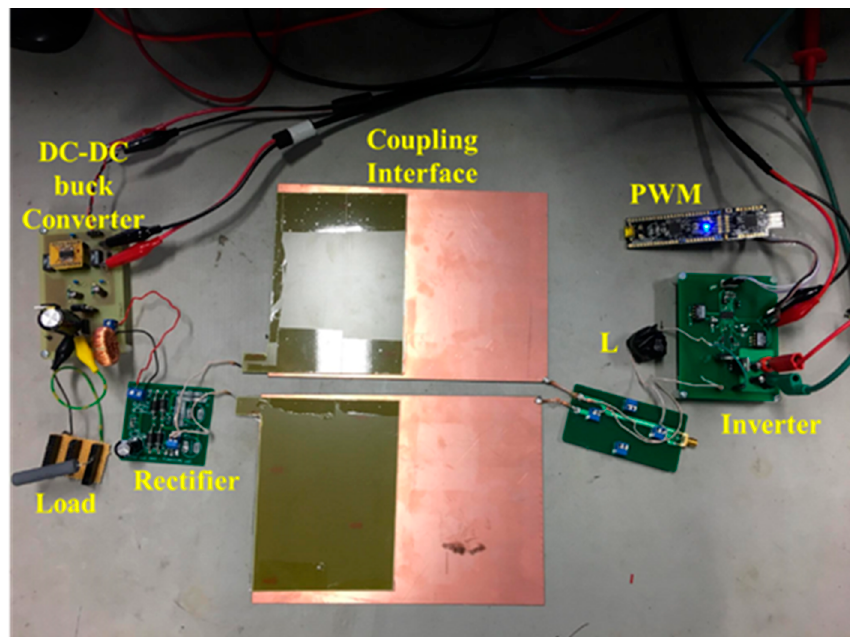
Figure 13. The system prototype. PWM: pulse-width modulation. Table 3. Circuit parameters and system specifications.